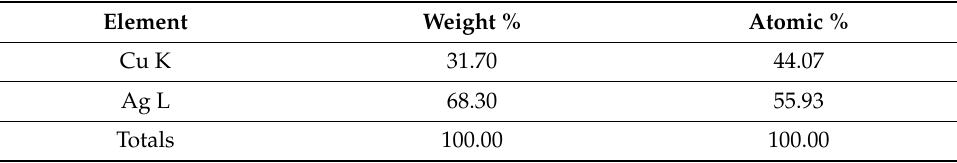
Table 1. The number and percentage of chemical elements present in EDX spectrum of P. nicotinovo- rans MAHUQ-43-mediated synthesized